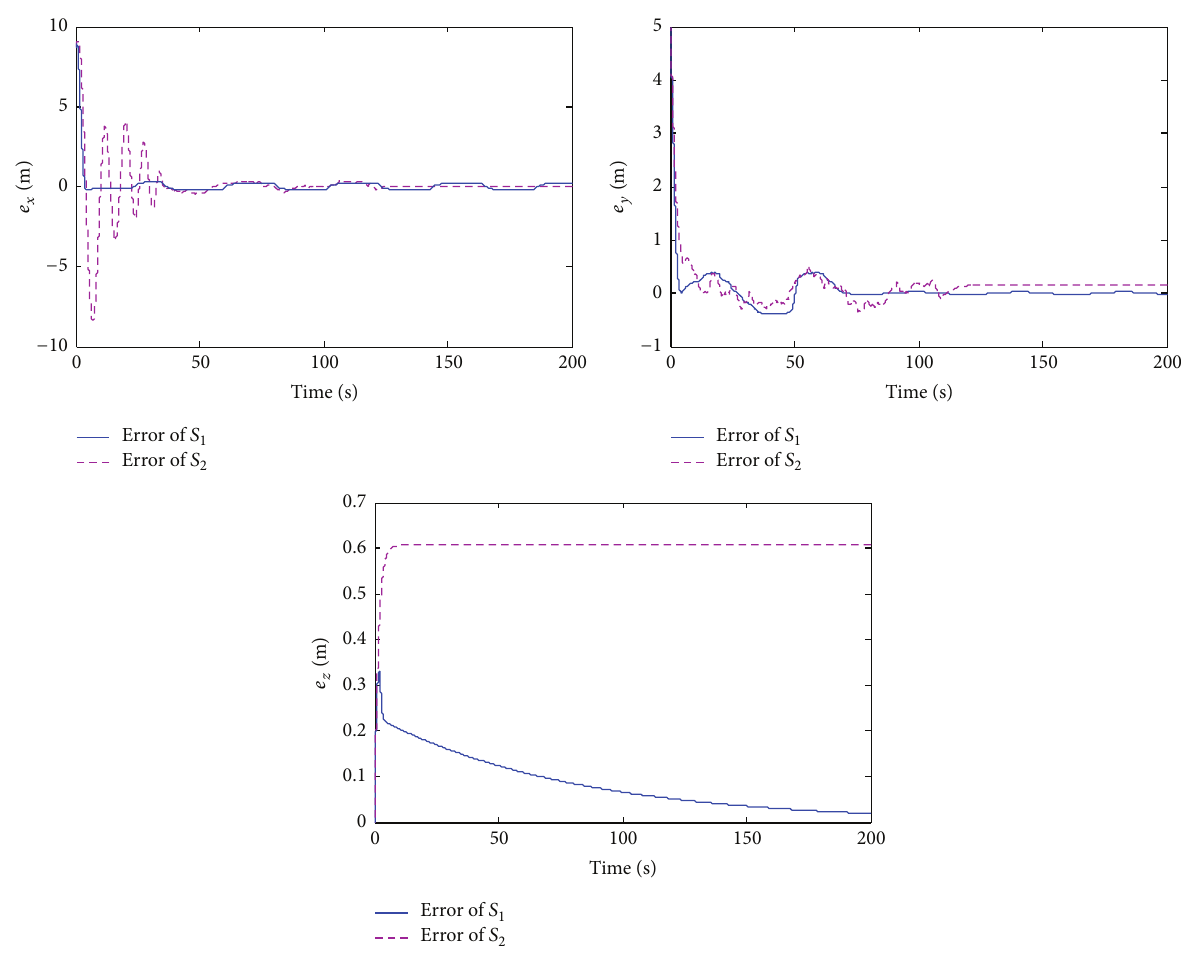
Figure 6: The tracking errors of the positions (𝑥,𝑦,𝑧)